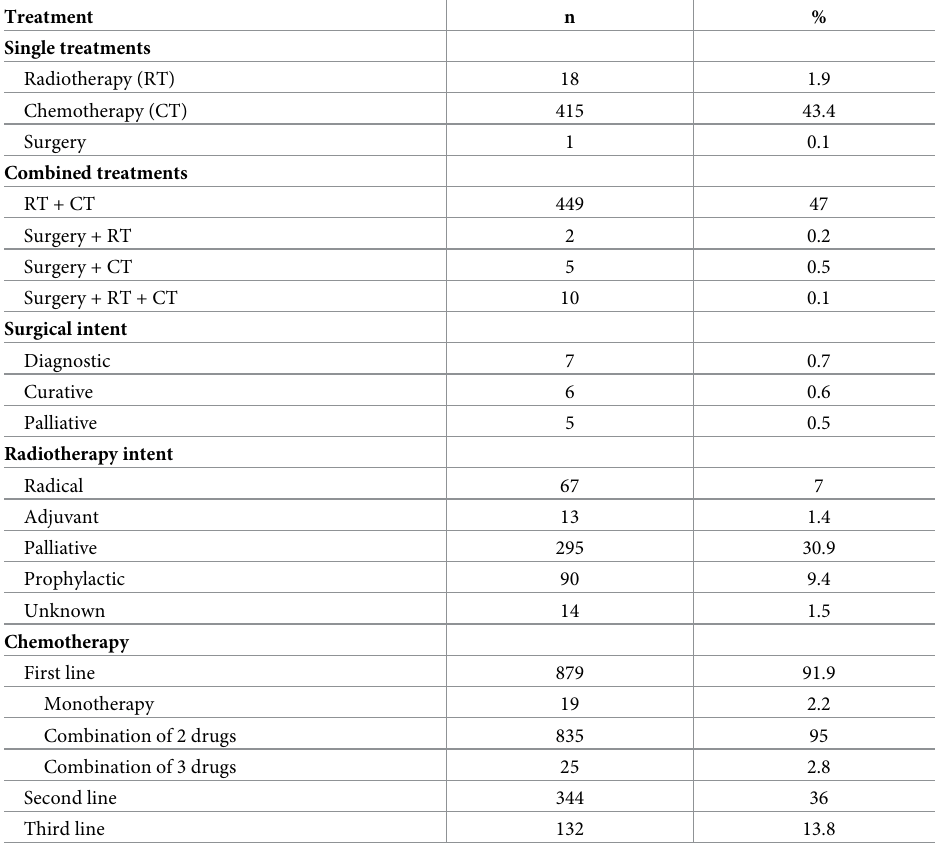
Table 2. Treatment characteristics.